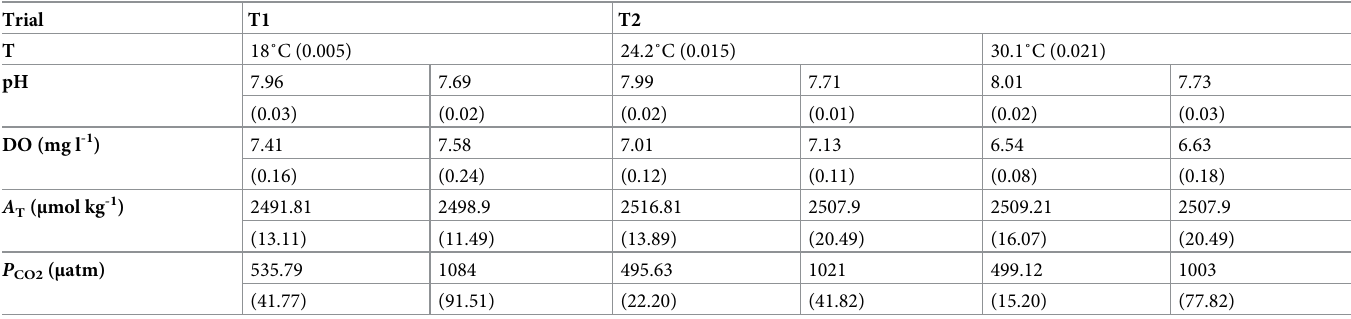
Table 1. Temperature (T), pH (pH T25 ), Dissolved Oxygen (DO), total alkalinity (A T ) and P CO2 in the six experimental